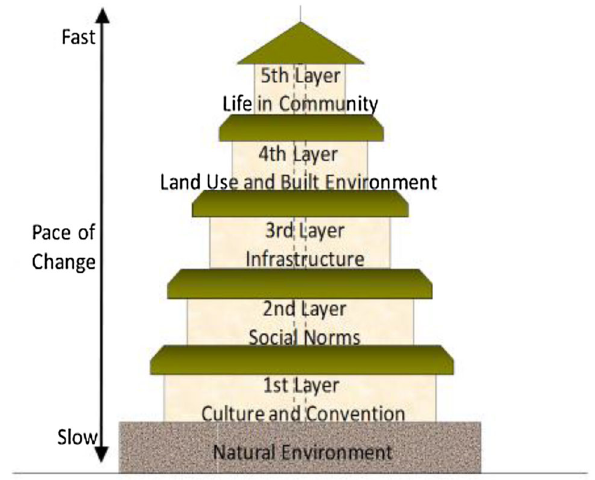
Fig. 1 Five-story pagoda model of the common spaces in a city, region, or neighborhood